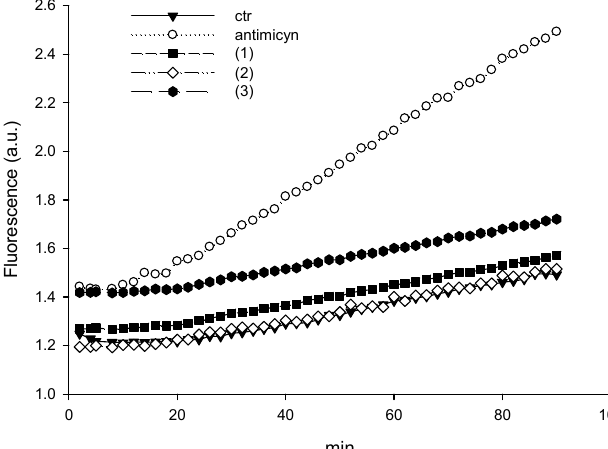
Figure 5. ROS production in LoVo cells. LoVo cells were initially loaded for 20 min at 37 °C with 10 mM CM-H 2 DCFDA in PBS. Subsequently, cells were treated with 15 μ M of copper(II) complexes. Fluorescence intensity of DCFDA was detected.